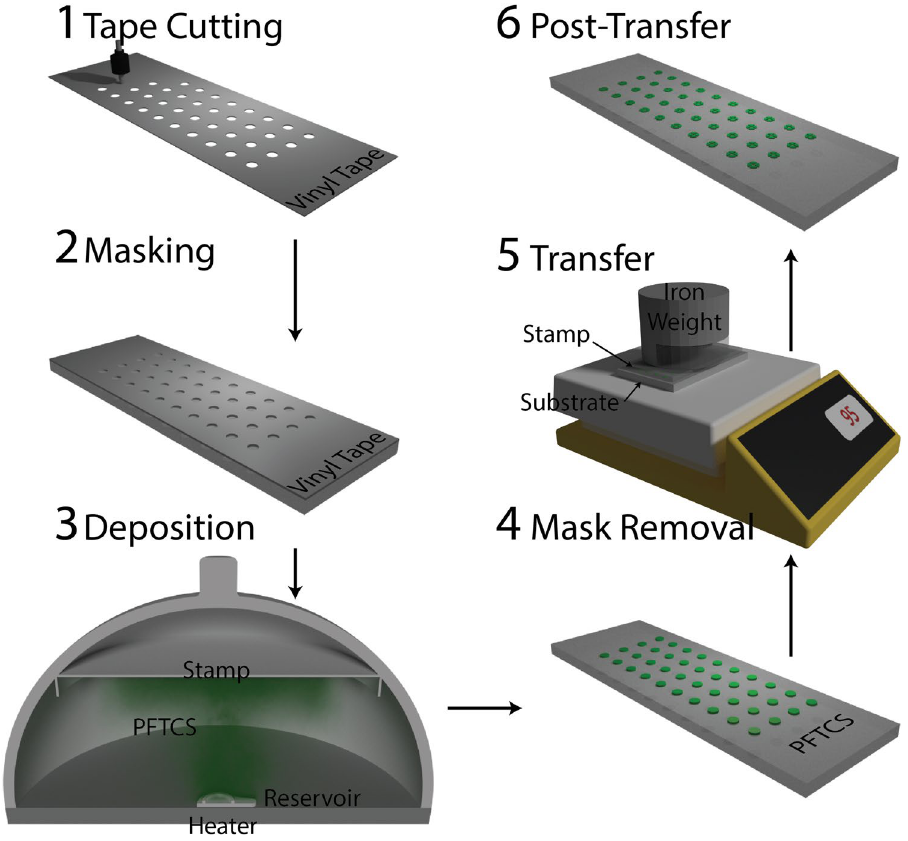
Figure 1. Overview of the deposition and stamping procedure. (1) A vinyl tape mask is cut based on the desired selective bonding pattern. (2) This mask is applied to a PDMS slab that will act as the stamp.